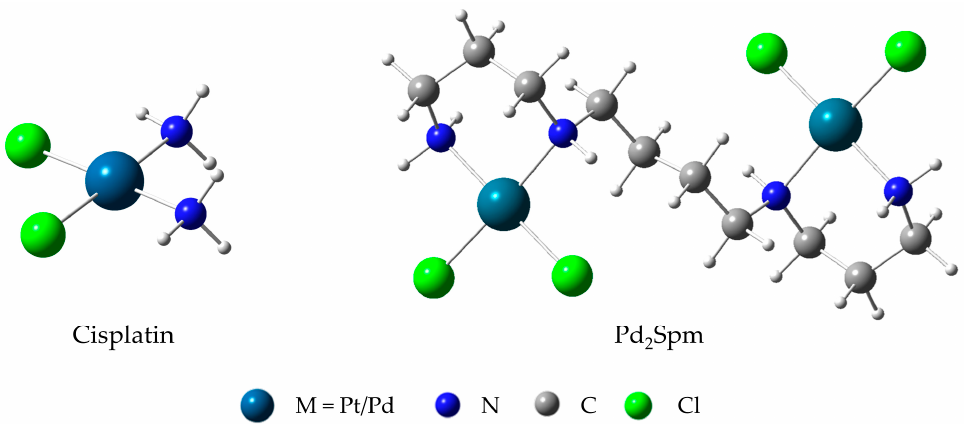
Figure 1. Structural representation of the Pt(II) and Pd(II) complexes presently studied.